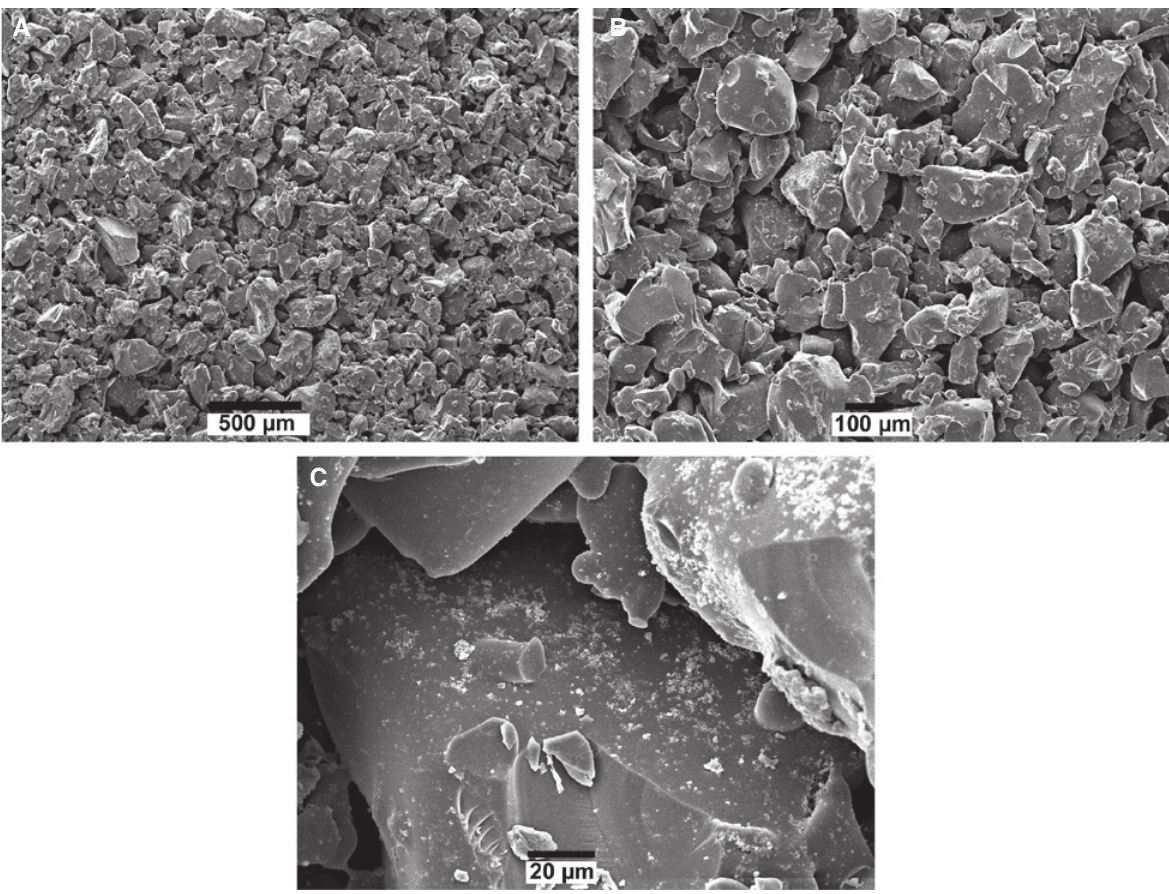
sintered at 800 ° C for 20 min at different magnifications, (A) low, 2